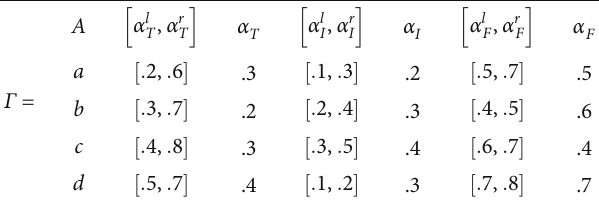
Table 6: Neutrosophic membership functions for vertices.